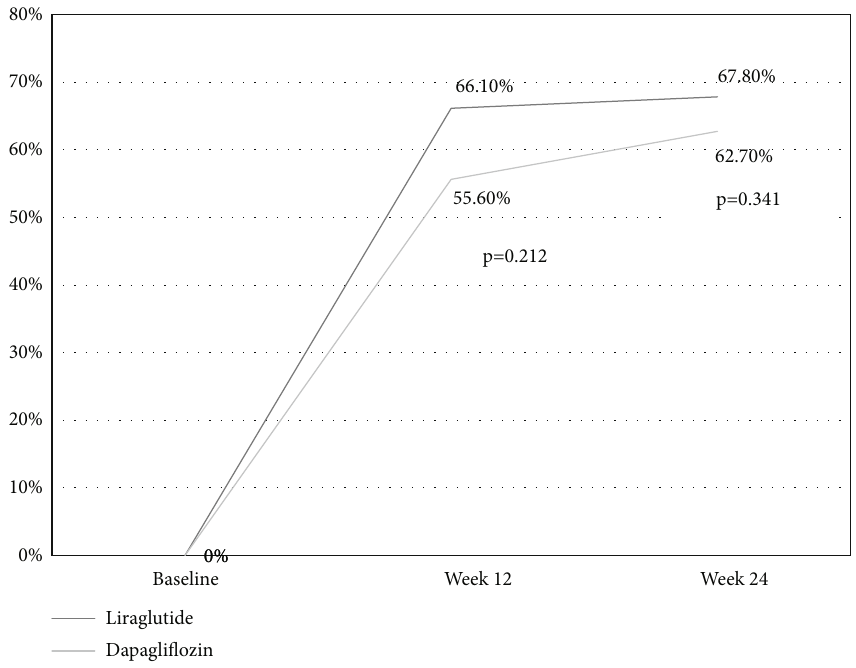
Figure 3: Comparison of HbA1c compliance rate ( < 7.0%) between the two